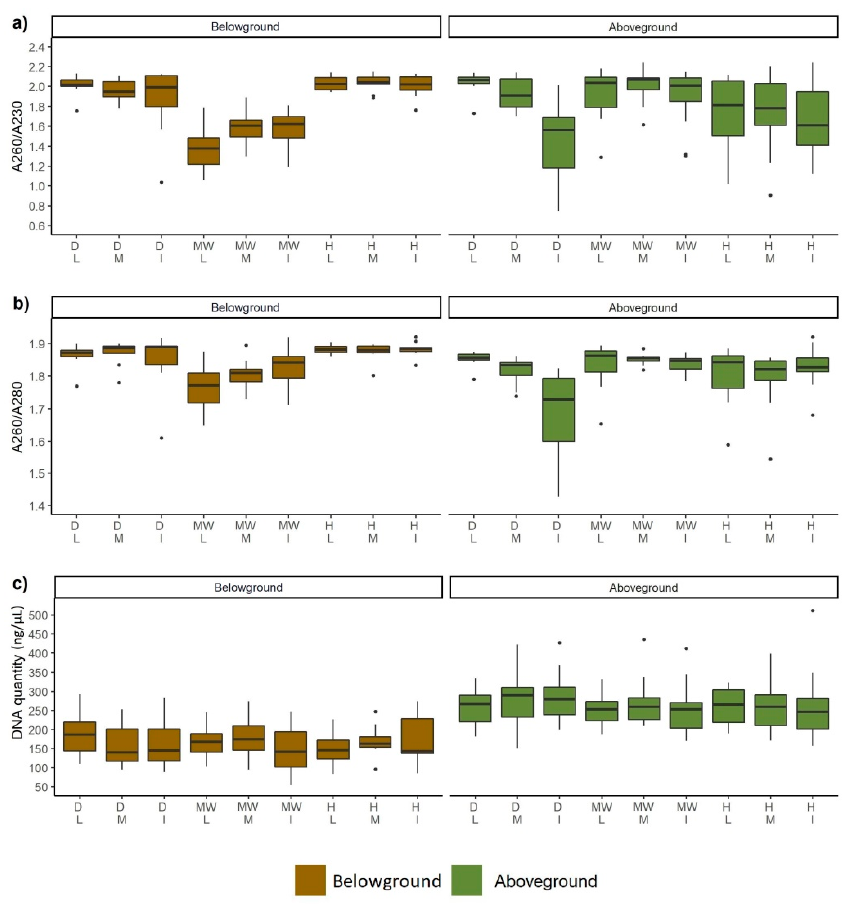
Figure 5. Comparison of quality ( a , b ) and yield ( c ) of DNA extracted from various meadow types. The horizontal line denotes the median values, the box indicates the first and third quartiles, and the points indicates outliers. For abbreviations see Figure 3.